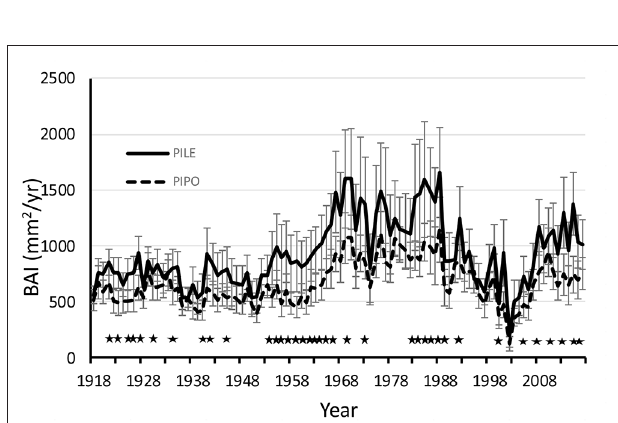
FIGURE 4 | Basal area increment (BAI) in time series from 1918 to 2017 of Pinus leiophylla (PILE) and P. ponderosa (PIPO). Stars indicate significant differences between the species. Error bars are 95% confidence